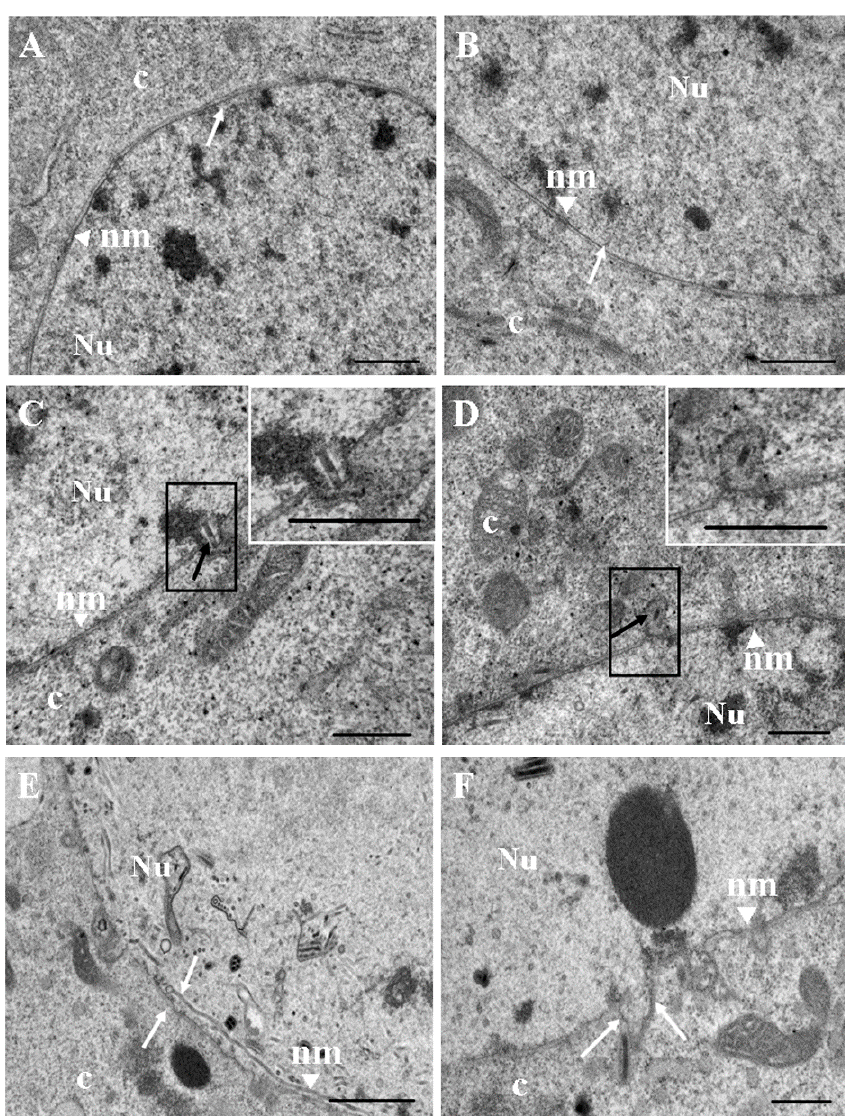
Figure 2. Electron microscopy of vAcBac-infected Sf9 cells. Panels ( A ) and ( B ) show the intact nuclear membrane in mock-infected cells and cells at 12 h post-infection (p.i.), respectively. The white arrows indicate the nuclear membrane. Panels ( C ) and ( D ) show the egress of nucleocapsids from the nuclear membrane at 24 h p.i. Inset shows the boxed region at higher magnification. The black arrows indicate the egress of progeny viral nucleocapsids from the nuclear membrane. Panel ( E ) and ( F ) show the remodeled nuclear membrane at 48 h p.i.. The white arrows indicate variation within the nuclear membrane. Bar, 500 nm (A,B,C,D,F), and 1000 nm (E). Nu, nucleus; c, cytoplasm; nm, nuclear membrane.